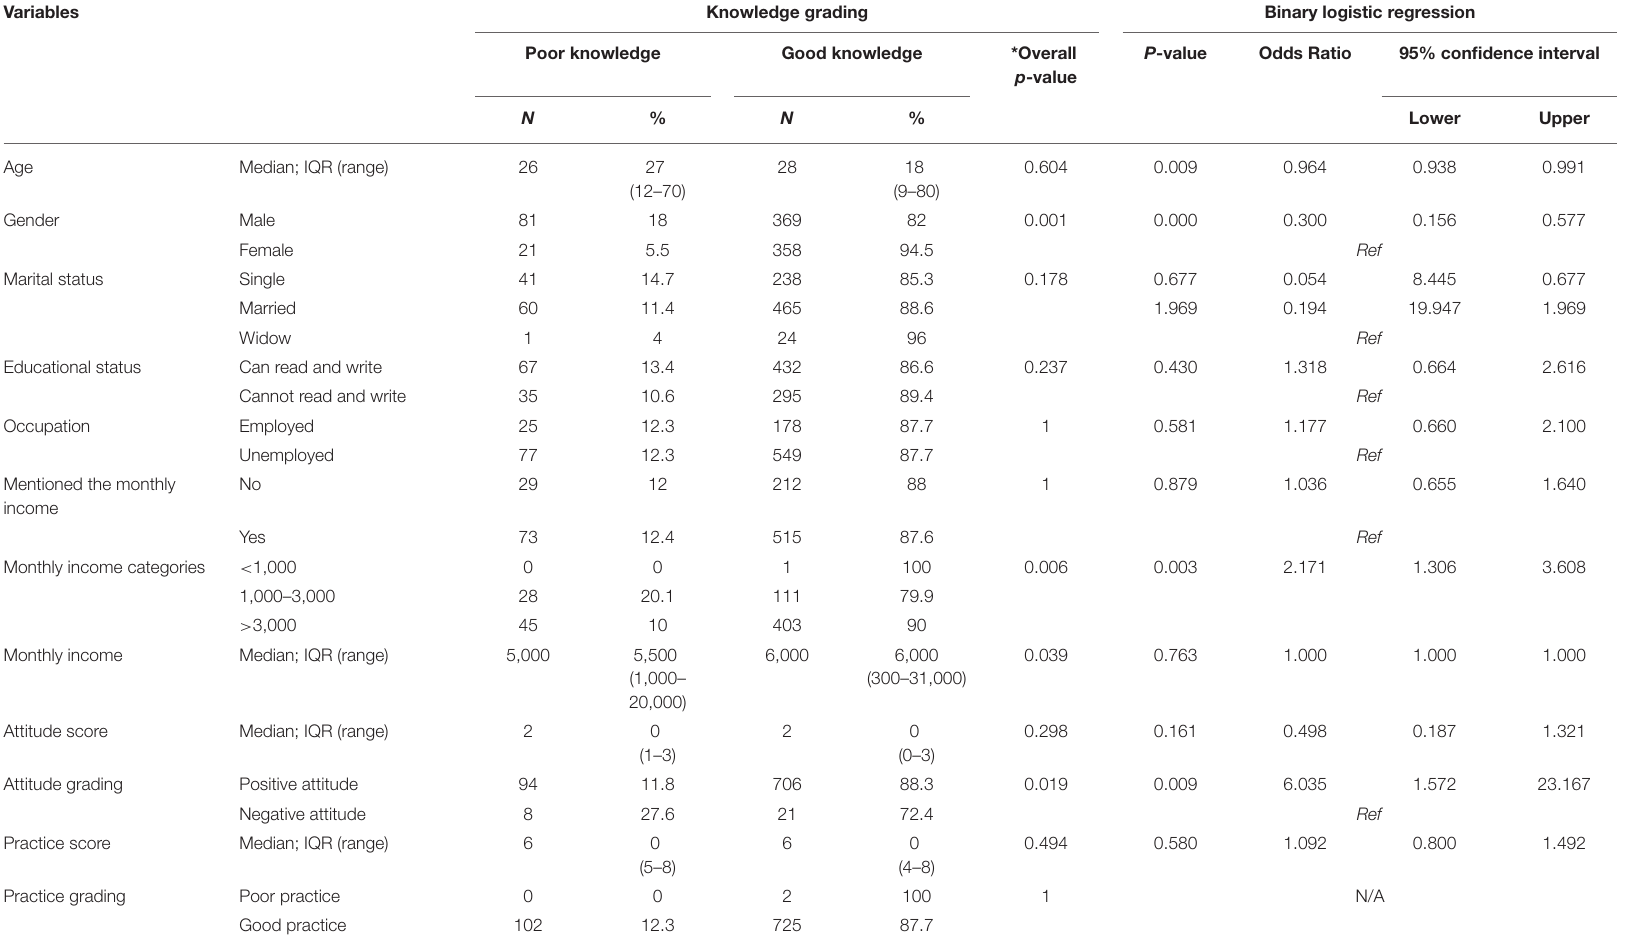
TABLE 3 | Knowledge and associated factors ( N = 829